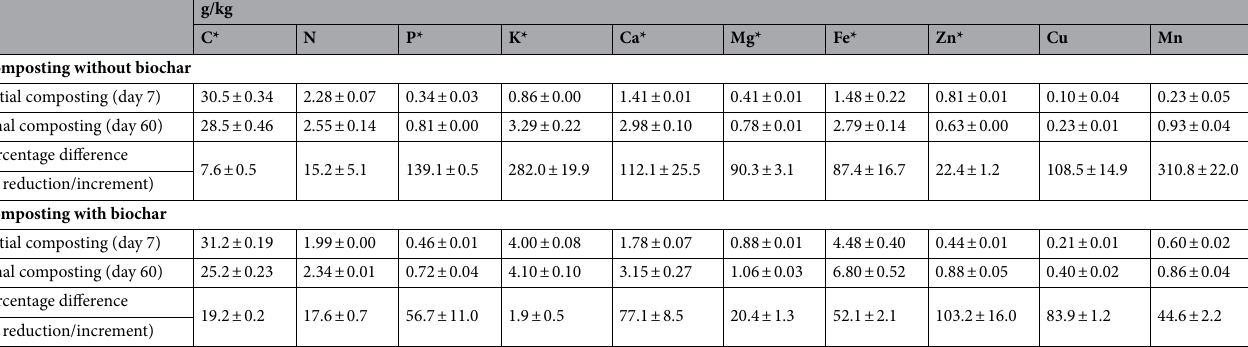
Table 2. Characteristics of initial mix and final product of rice straw and chicken manure composting with and without biochar addition. The symbol (*) indicates a significant difference at P ≤ 0.05 between the